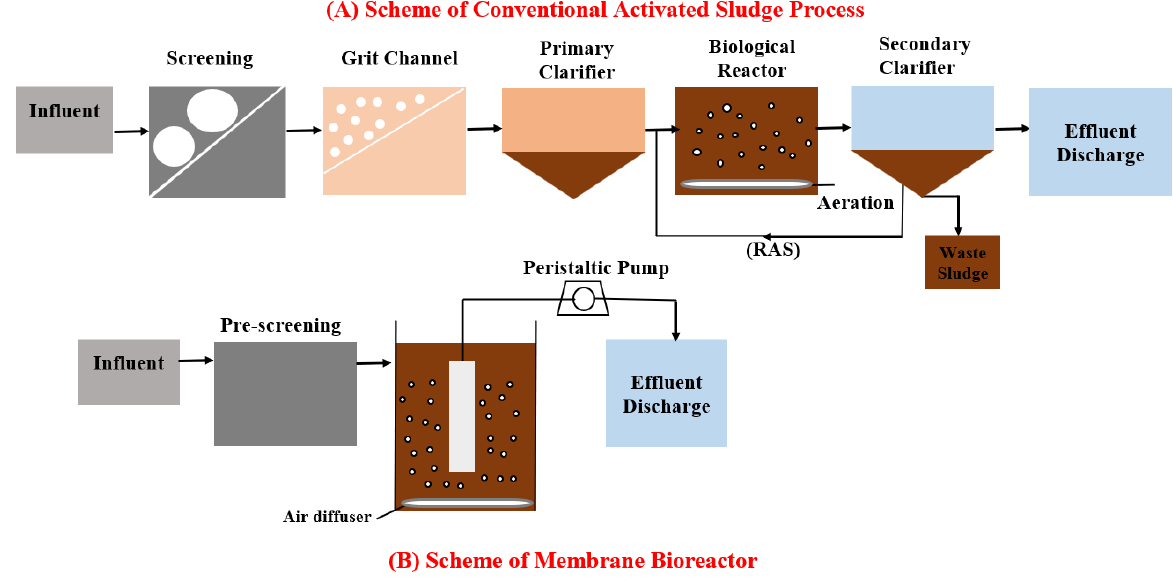
Figure 1. The scheme of the conventional activated sludge process ( A ) and the MBR process ( B ).